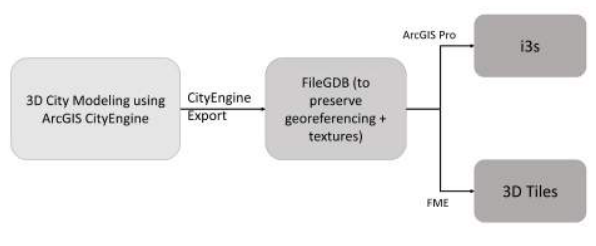
Figure 4. ArcGIS CityEngine to